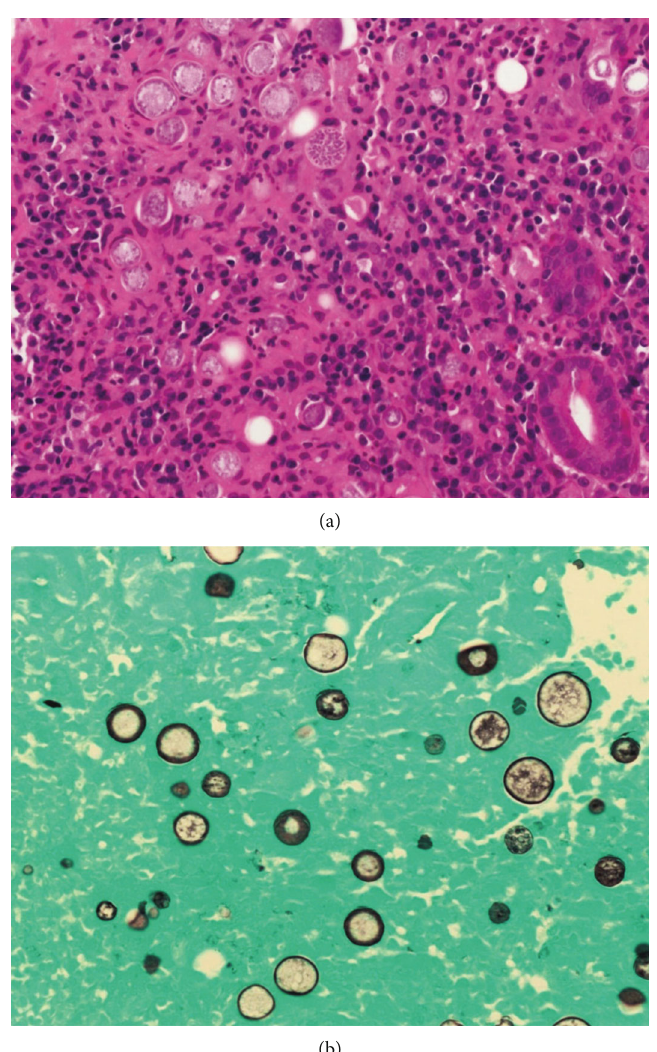
Figure 5: Duodenal biopsy shows multiple spherules fi lled with round fungal endospores, and dispersed isolated endospores can be seen in the lamina propria on H&E stain (a) and GMS stain (b). (Images obtained with permission from Zhou et al.